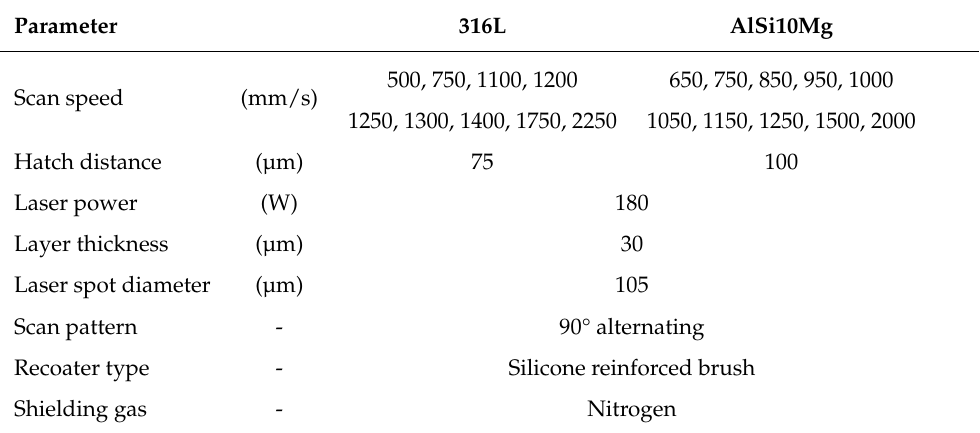
Table 1. Powder bed fusion (PBF) process